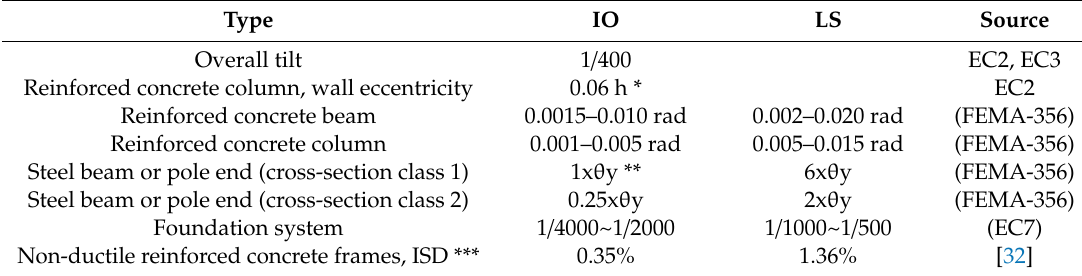
Table 1. Damage limits examples